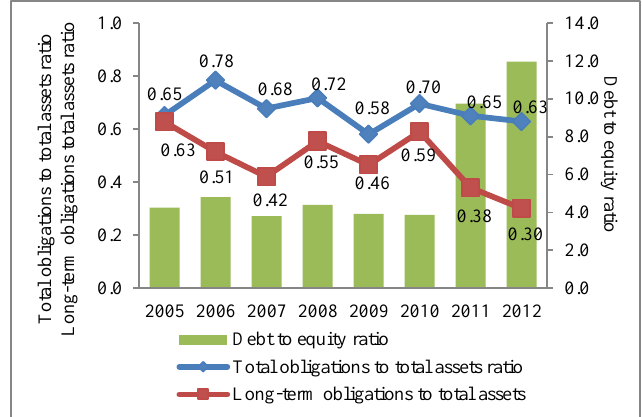
Fig. 1. Changes of the financial leverage ratios of companies producing electricity in wind power plants in Latvia during 2005 – 2012 (own